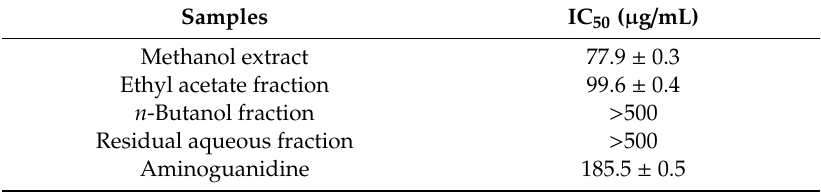
IC 50 values represent the mean ± SD ( n =